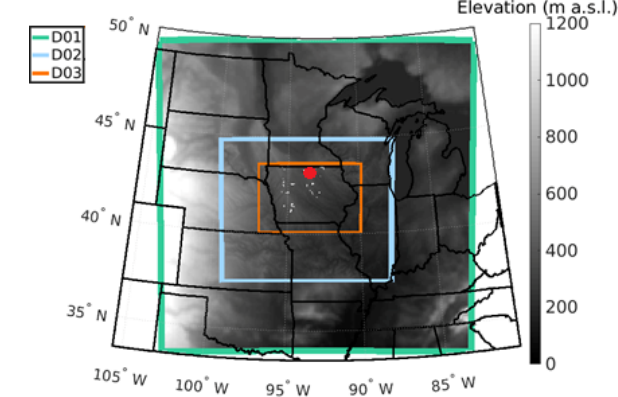
Figure 2. Terrain elevation and domains used in the WRF simula- tion (D01, D02) and the region from which wind profiles are ana- lyzed (D03). White markers indicate wind turbine locations in 2014 (Hoen et al., 2021). The red marker indicates the approximate loca- tion of the grid cell with the highest LLJ frequency that is examined in Sect.